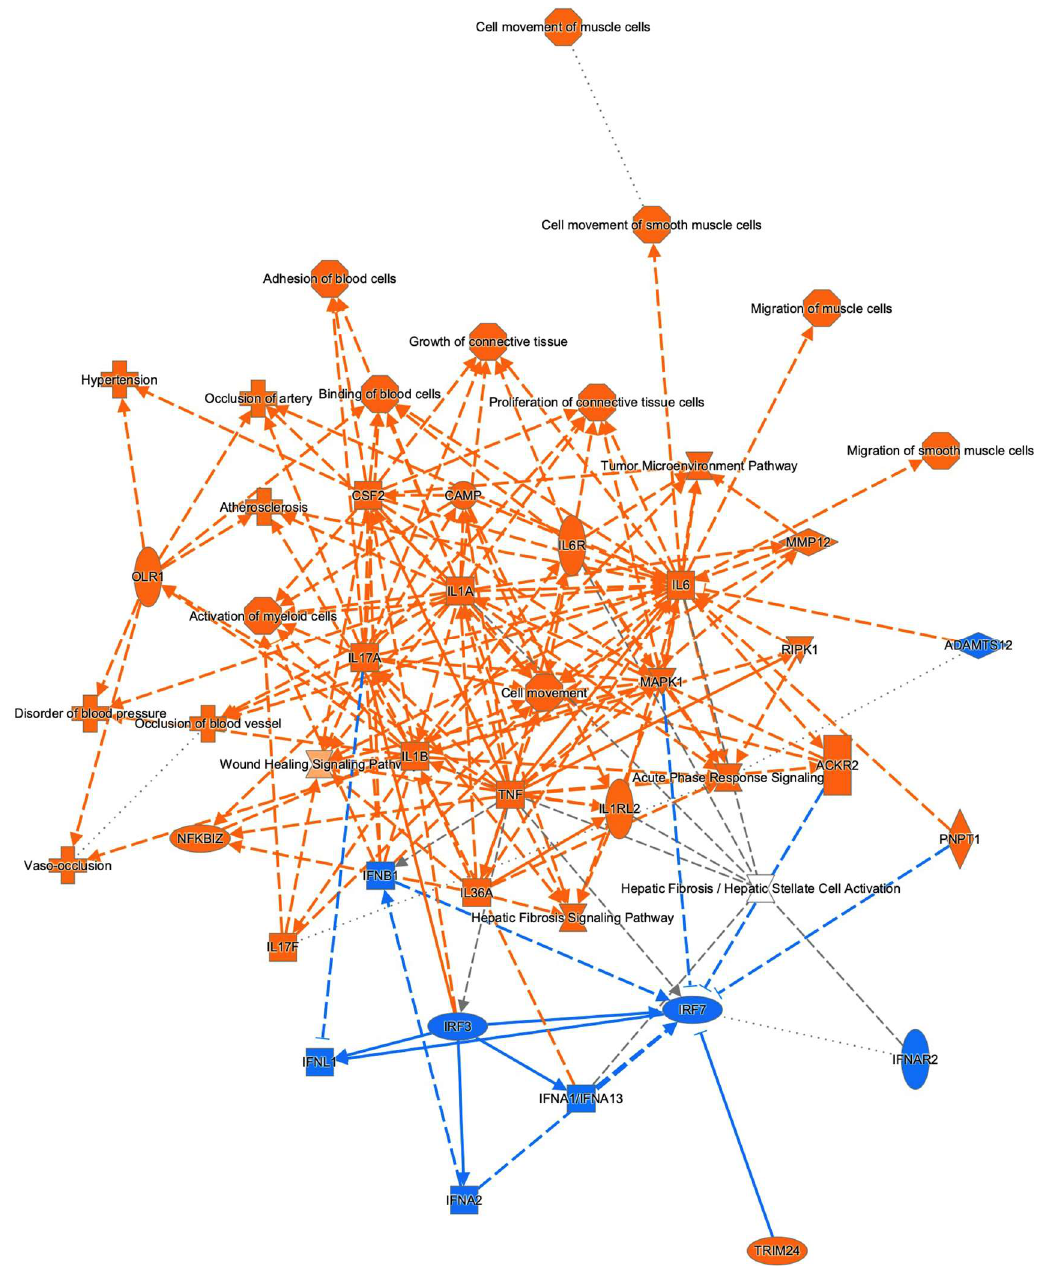
Figure 4. The graphical summary of the biological process network of DEGs. Prediction legend is shown in Figure S1.